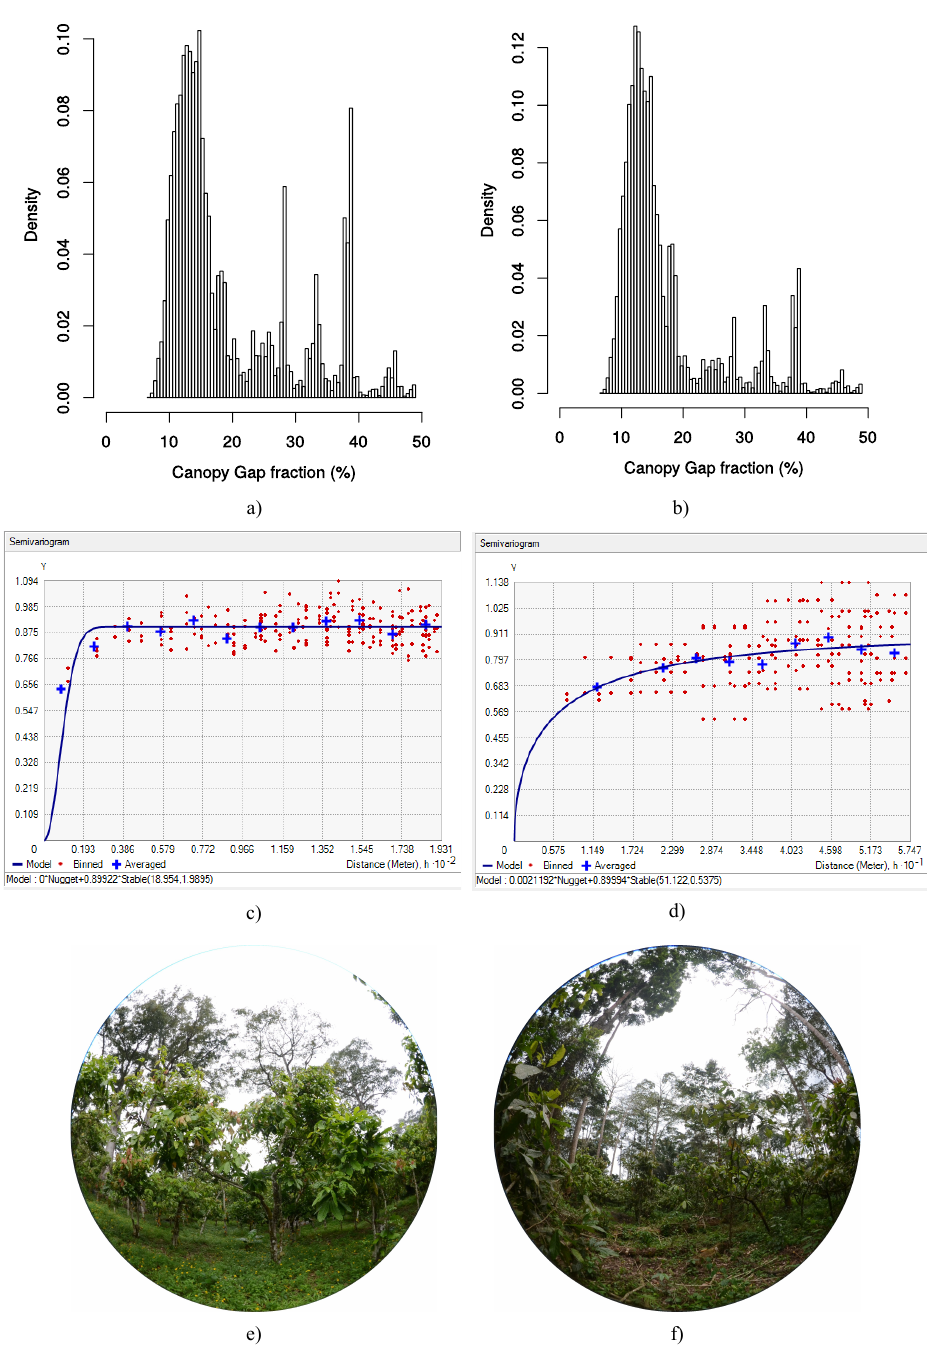
Figure 13. Experimental semi-variogram of the predicted canopy gap fraction by RF: ( a ) Histogram of the predicted canopy gap in the Bokito site. ( b ) Histogram of the predicted canopy gap in the Efoulan site. ( c ) Semi-variogram of canopy gap distribution in Bakoa-Guefige landscape (Bokito site). ( d ) Semi-variogram of canopy cover distribution in Minkane-Minto landscape (Efoulan site). Field view, from a fisheye wide angle lens (180 ◦ view angle), of the density and distribution of shade (or canopy) trees typical of mature CAFS in ( e ) the Bokito site and ( f ) the Efoulan